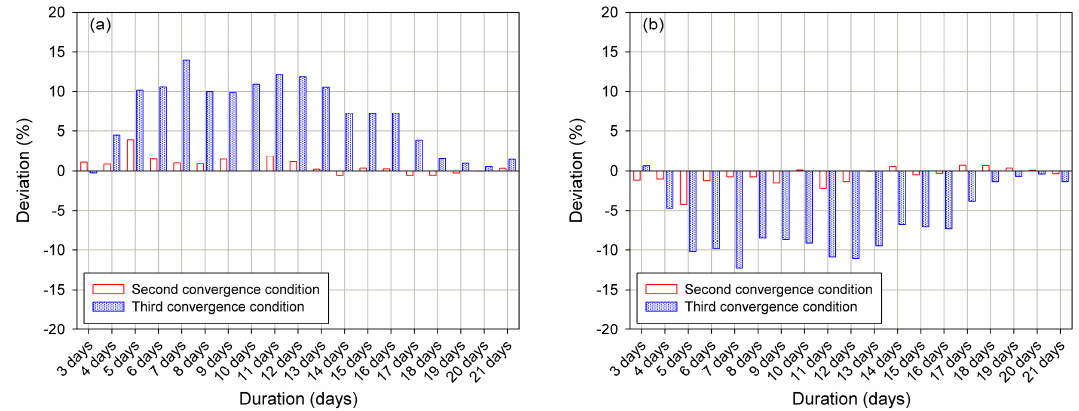
Figure 4. Deviation of ( a ) R -value and ( b ) U -value according to convergence conditions of the ISO 9869-1 standard.